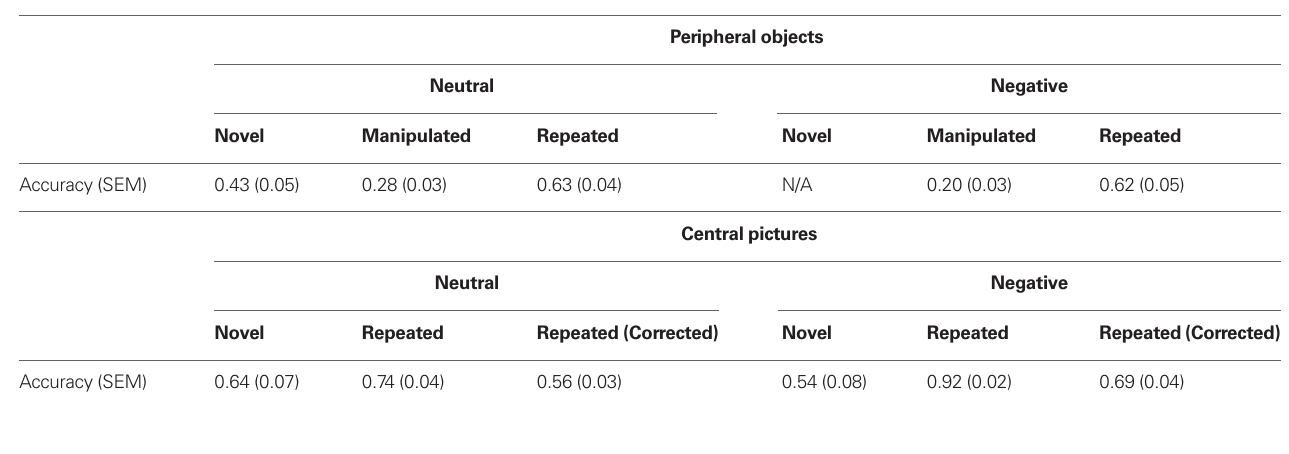
Table 2 | Mean responses and standard errors for peripheral objects and central